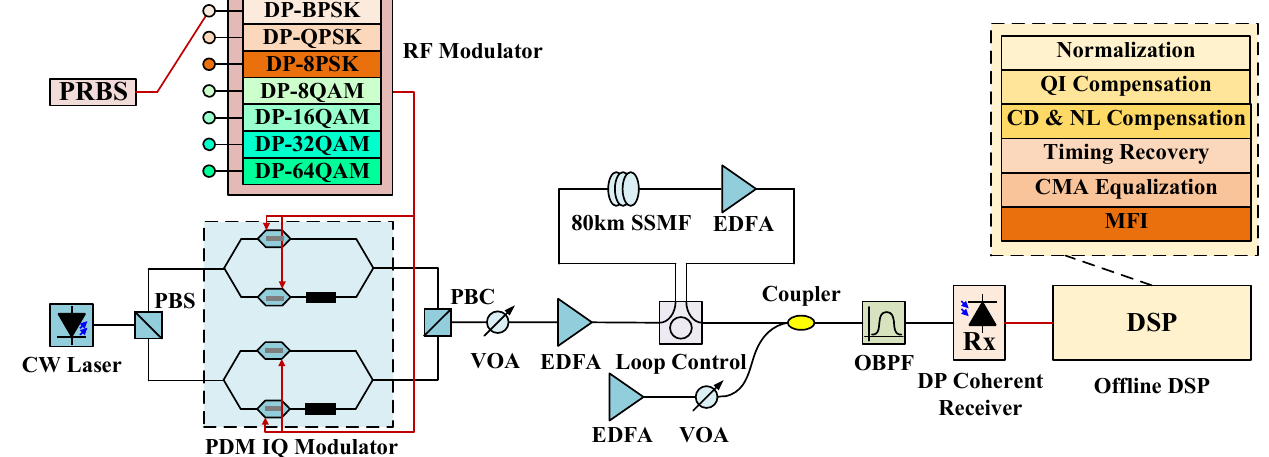
Figure 5. Simulation setup of the proposed blind MFI method.